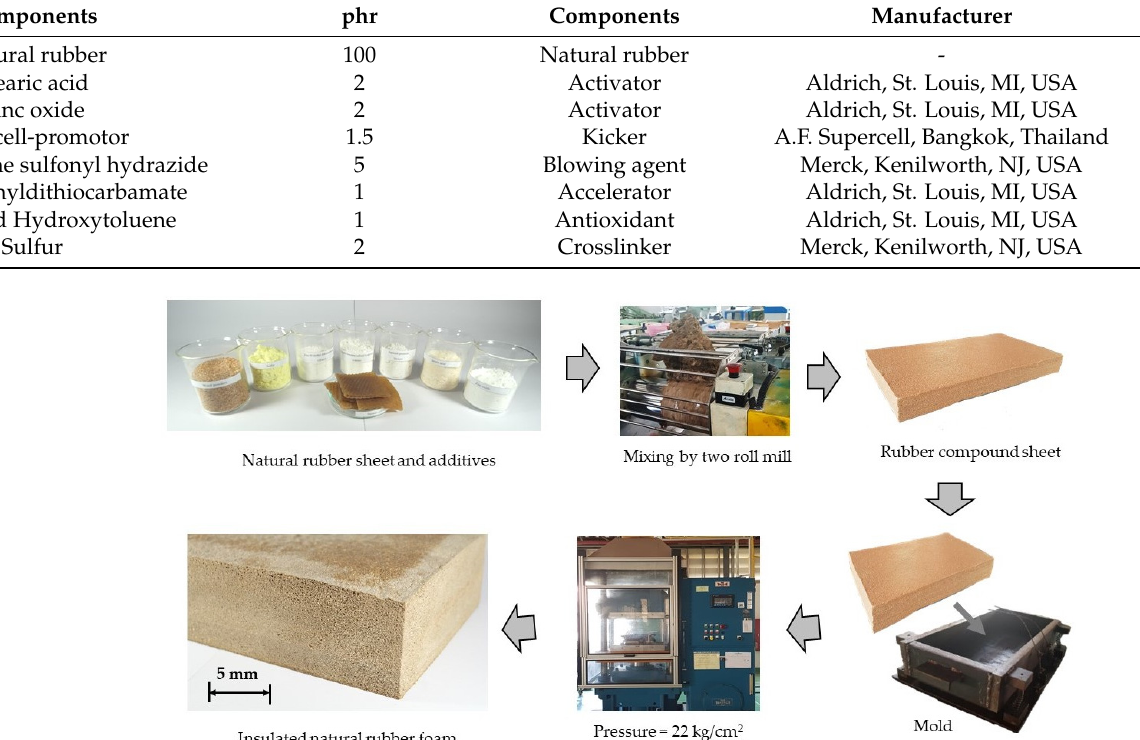
Table 1. Dimensions of the plywood, cement particleboard, and fiber-cement board used in this research.